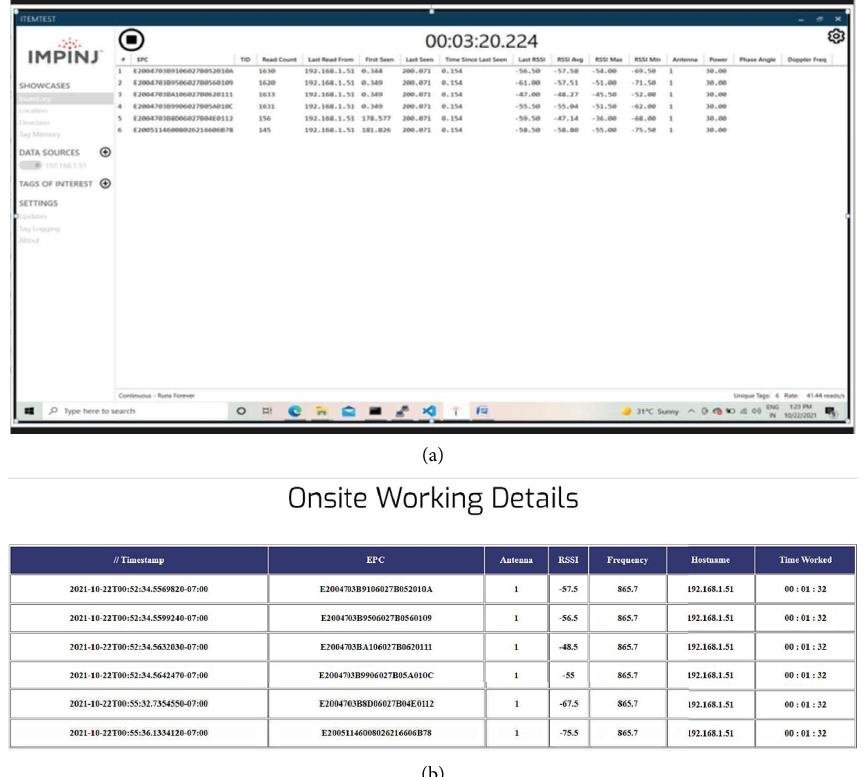
Figure 25: (a) Tagged workers being recognized by item test software from Impinj. (b) Details of on-site workers being displayed on a developed web application.